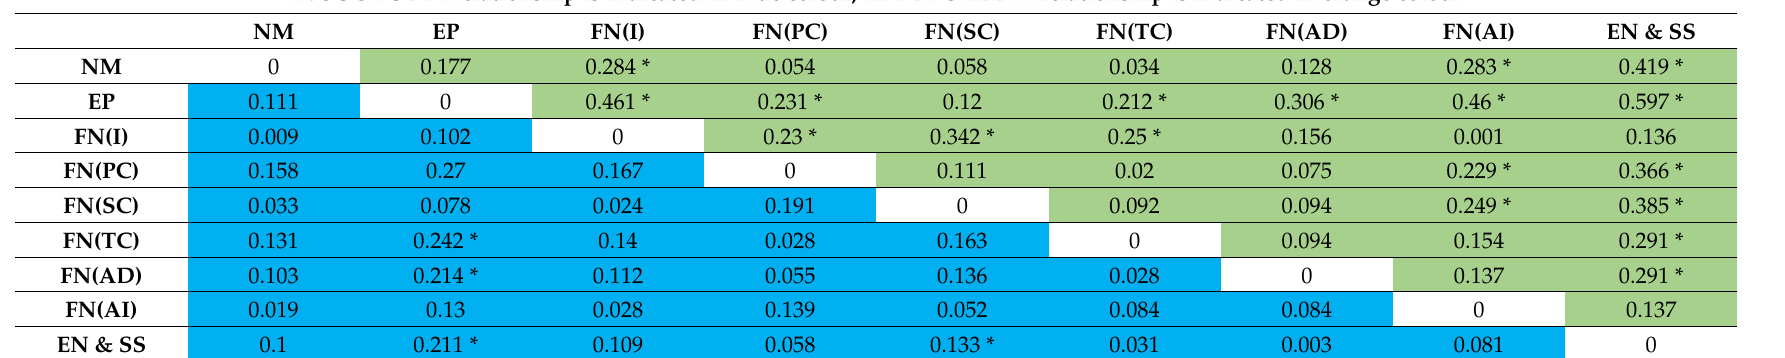
D. SOURCE-BI relationship is indicated in Blue colour; AFTER-SALE-BI relationship is indicated in orange